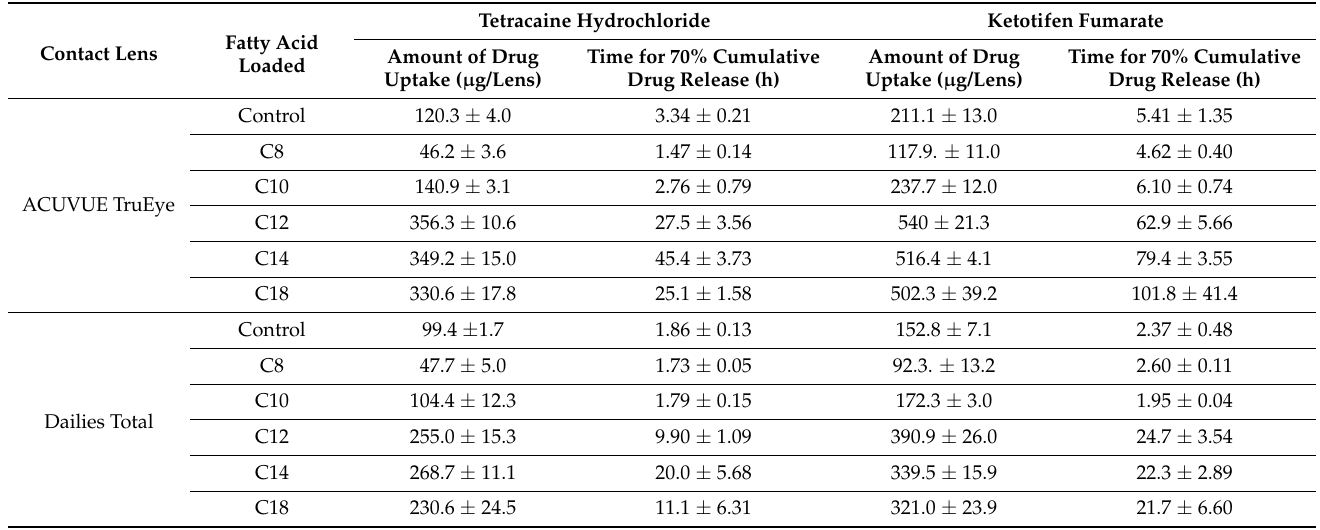
Table 3. Summary of THCL and KTF release experiments evaluating the effect of hydrocarbon chain length of fatty acid. Data are presented as mean ± standard deviation with n =